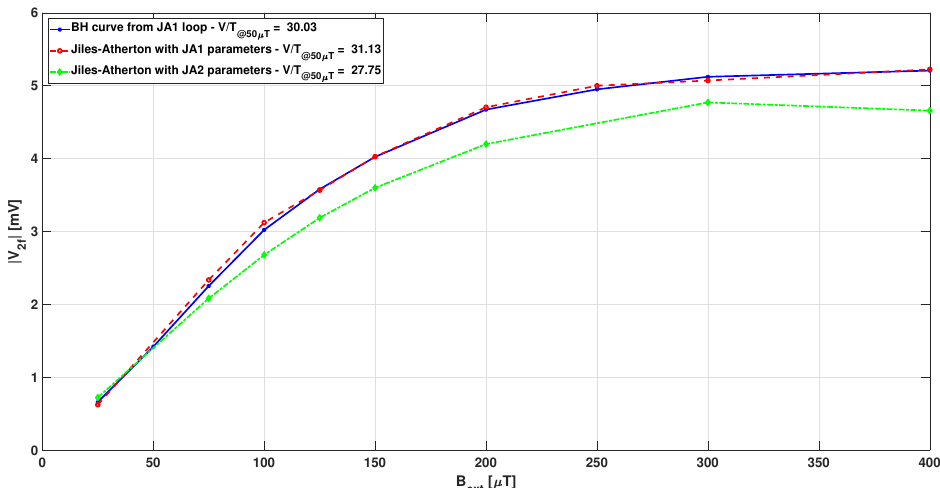
Figure 19. Second harmonic of the output voltage against the related external magnetic field for the different analyzed cases: non-hysteretic JA1 model (solid blue), hysteretic JA1 (dashed red), and JA2 (dahed-dotted green)